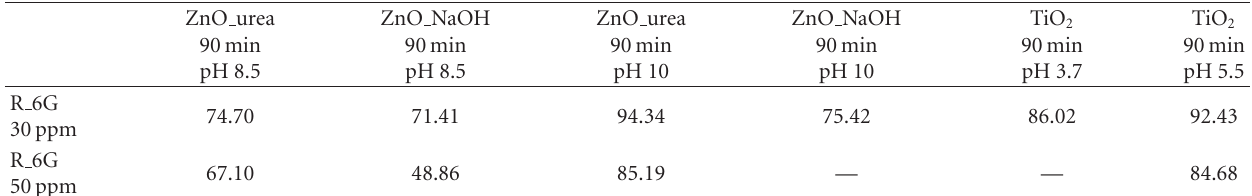
Table 1: Selected results on photocatalytic activities of the ZnO and TiO 2